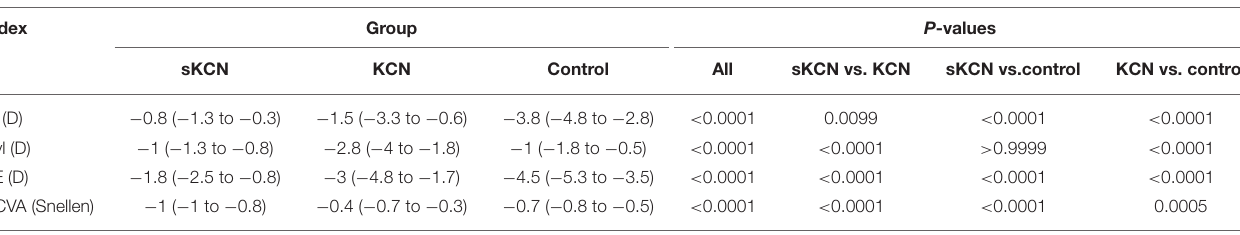
TABLE 2 | Refractive parameters and visual acuity of patients in sKCN, KCN and Control group.